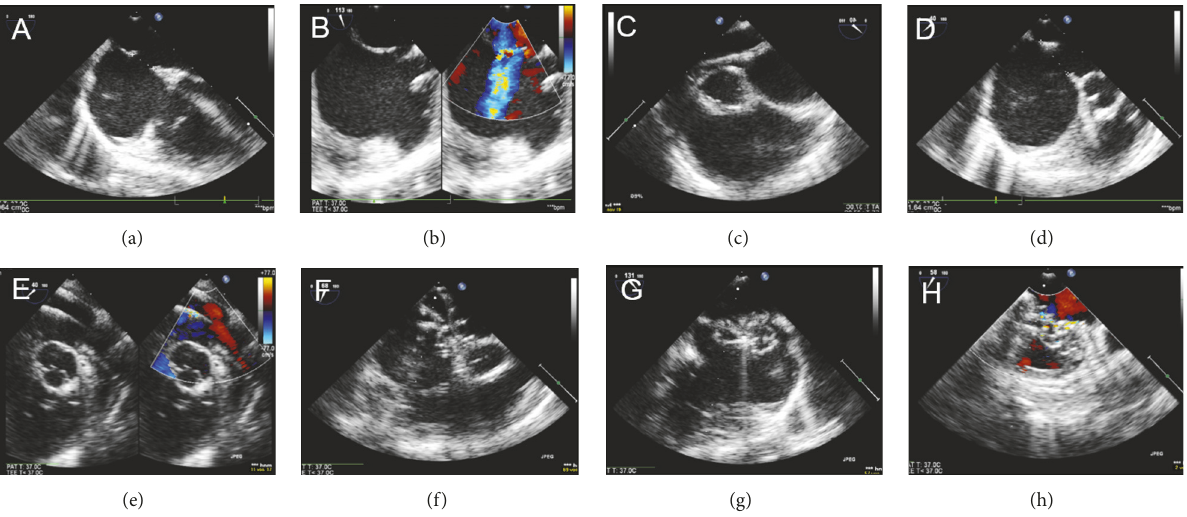
Figure 2: Illustration of interventional ASD device closure with a GORE Cardioform Septal Occluder using exclusively transesophageal echocardiography guidance. Standardized “step-by-step” procedural imaging guidance. ((a)+(b)) Imaging of the native defect, screening the defect and its rims from 0 ∘ -120 ∘ , focusing on standardized views in approximately 0 ∘ , 30 ∘ , 60 ∘ , 90 ∘ , and 120 ∘ . (c) Guidance of catheter passage acrossthedefectintotheleftupperpulmonaryvein(LuPV).(d)“Stretched”ASDdiameterafterstiffguidewireplacementthroughthecatheter into LuPV. (e) Illustration of large sheath insertion into LuPV. (f) Guidance of device deployment into the defect. ((g)+(h)) Illustration of device position after implantation in different views, again screening the defect and device from 0 ∘ -120 ∘ , focusing on standardized views in approximately 0 ∘ , 30 ∘ , 60 ∘ , 90 ∘ , and 120 ∘ .